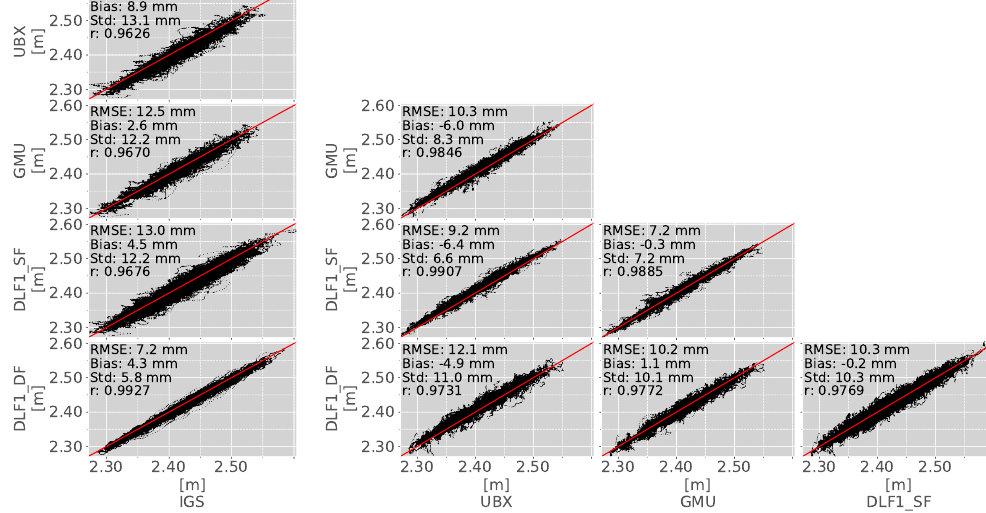
Figure 4. ZTD scatter plots of the reference dataset IGS, the dual-frequency PPP-processed DLF1 dataset, and the SEID-processed single-frequency data from UBX, GMU, and DLF1_SF utilizing the EUREF SEID constellation. The plots on the left depict the comparison of the goGPS dual-frequency estimation to the IGS reference dataset. The scatter plots on the right show the SEID and instrument errors. The observation period is from 1 September 2017 until 31 December 2017. The solid red line depicts the regression